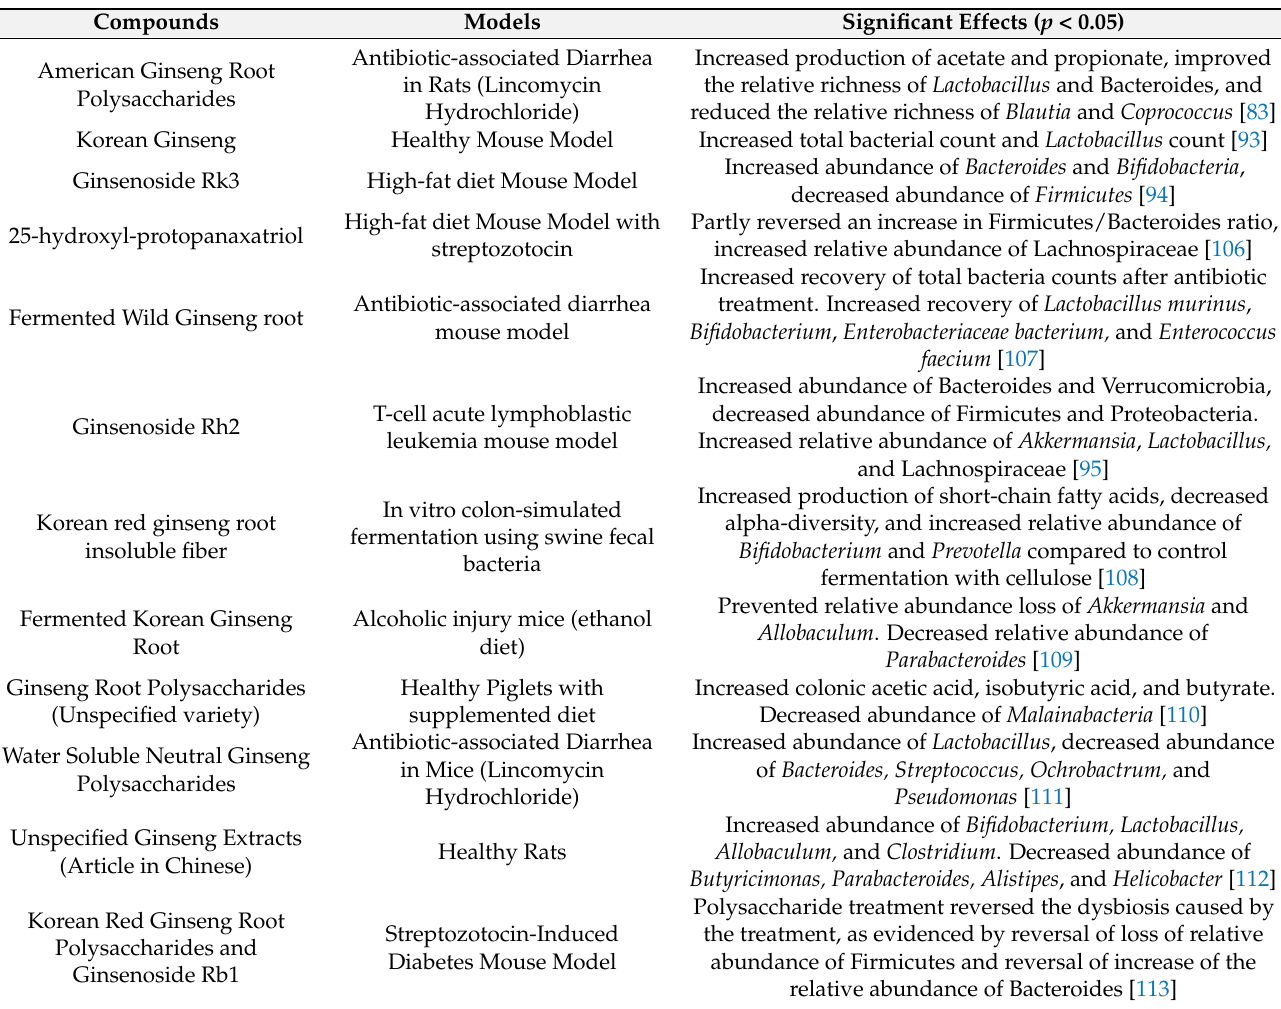
Table 3. Direct effects of ginseng on the intestinal